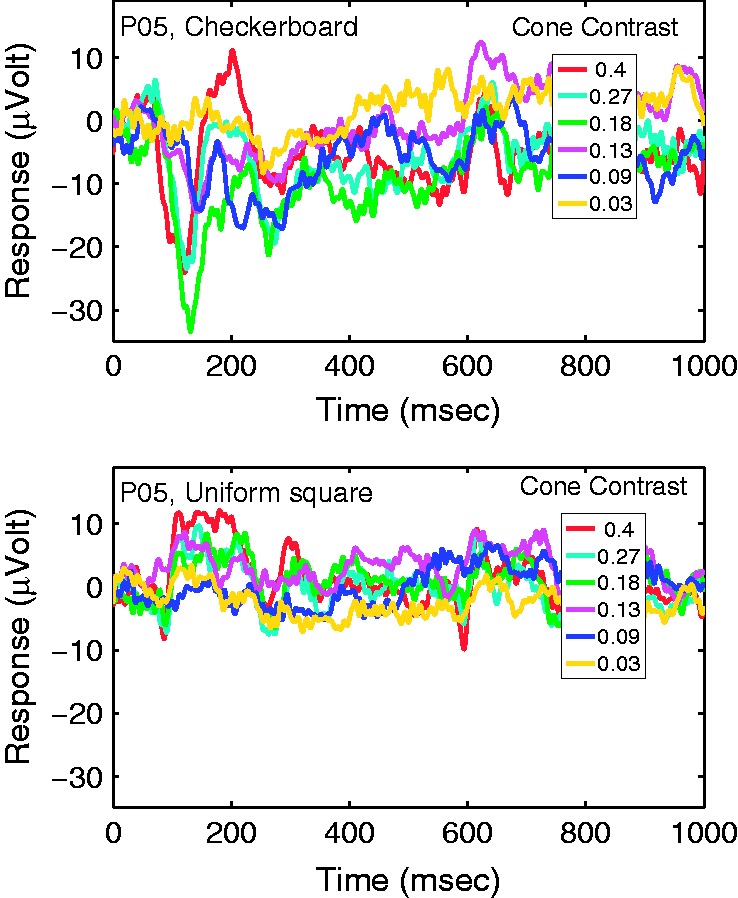
The cVEP waveform at electrode Oz for a typical participant observing the
checkerboard (top) and uniform-square (bottom) patterns. For both stimuli, responses
are plotted for a selection of cone contrasts, covering the time period from pattern
onset to 1000 ms after pattern onset. Note that the pattern was visible only from 0
to 500 ms.